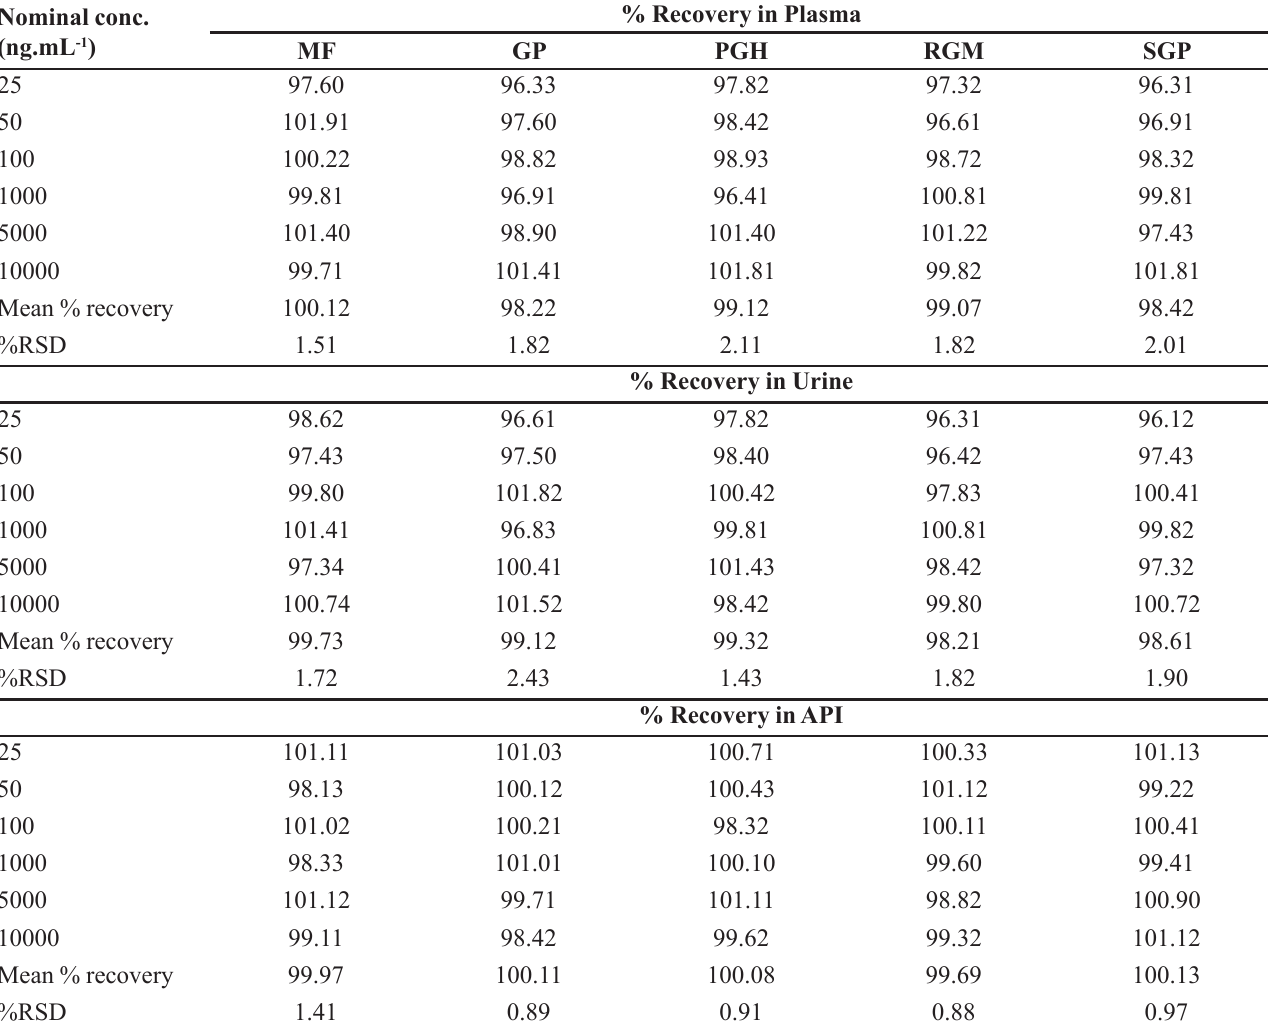
TABLE III - Applications of the method Nominal